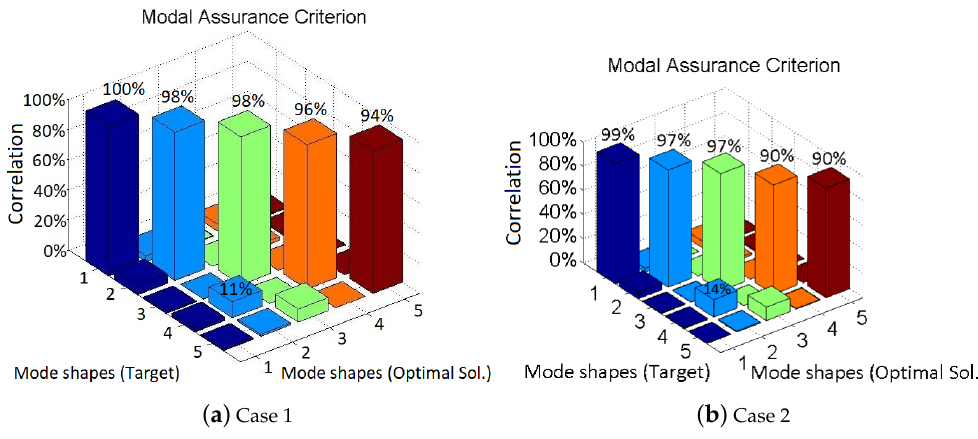
Figure 7. Modal Assurance Criterion for Cases 1 and